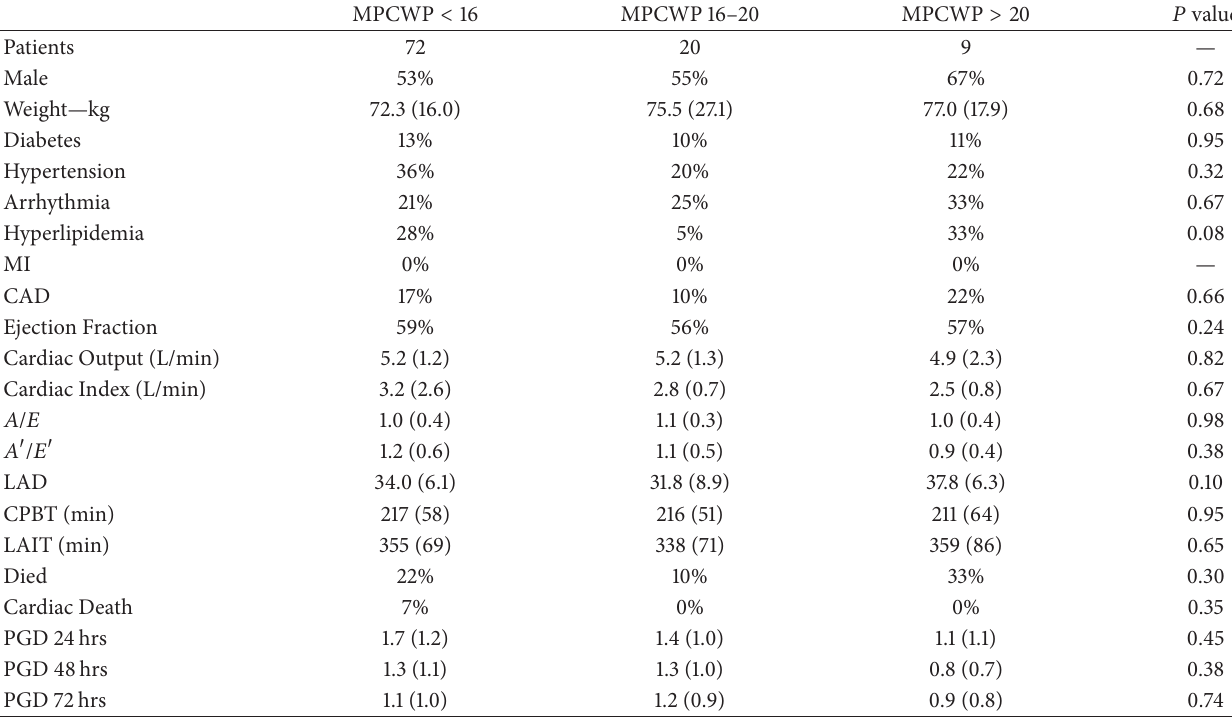
Table 2: Demographics between mean capillary wedge pressure (MPCWP). Numbers presented as mean (standard